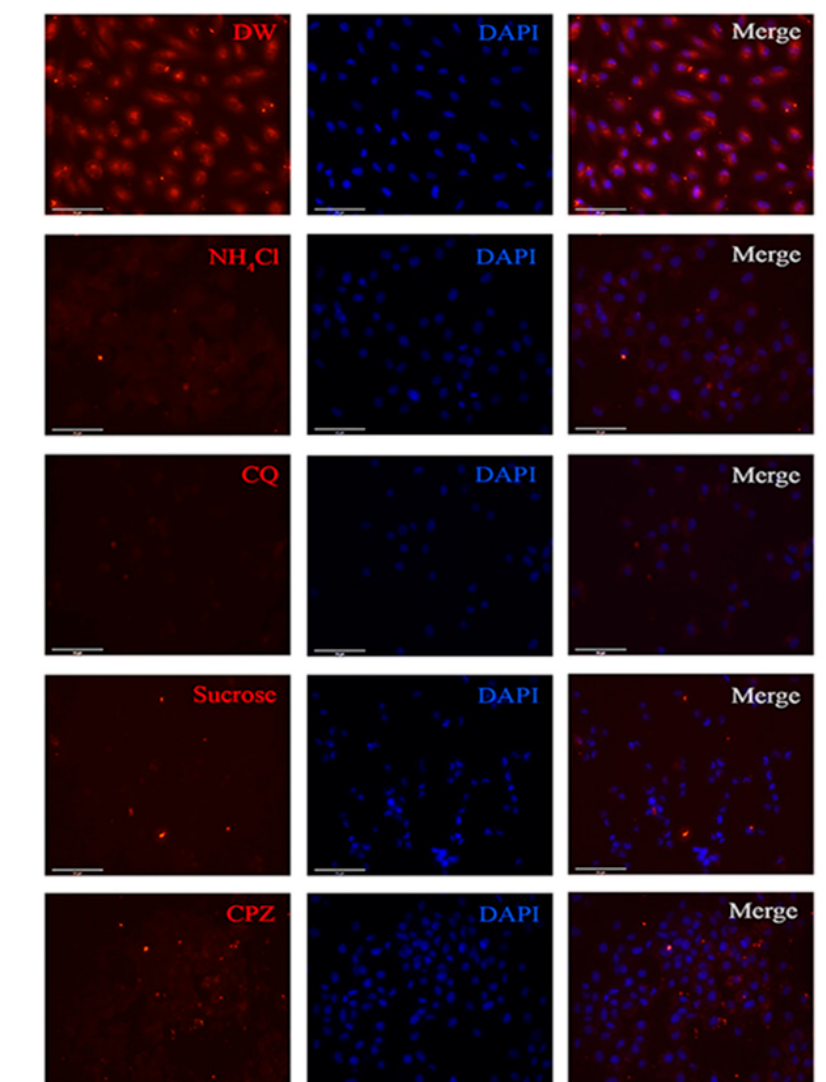
Figure 5. LCDV entry is pH- and clathrin-independent. FG cells were pre-incubated with NH 4 Cl ( A ), CQ ( B ), sucrose ( C ), or CPZ ( D ), and then infected with LCDV. LCDV copy numbers were detected by qPCR; the histogram represents virus copy numbers and the line graph represents cell viability. ( E ) FG cells were treated with 10 mM NH 4 Cl, 25 μ M CQ, 200 mM sucrose, or 10 μ M CPZ, then incubated with Alexa fluor 647 conjugated transferrin. The fluorescence intensity of transferrin in FG cells was observed using fluorescence microscopy; bars = 50 μ m. FG cells treated with distilled water instead of NH 4 Cl, CQ, sucrose or CPZ served as negative controls. Error bars represent SD ( n = 3).